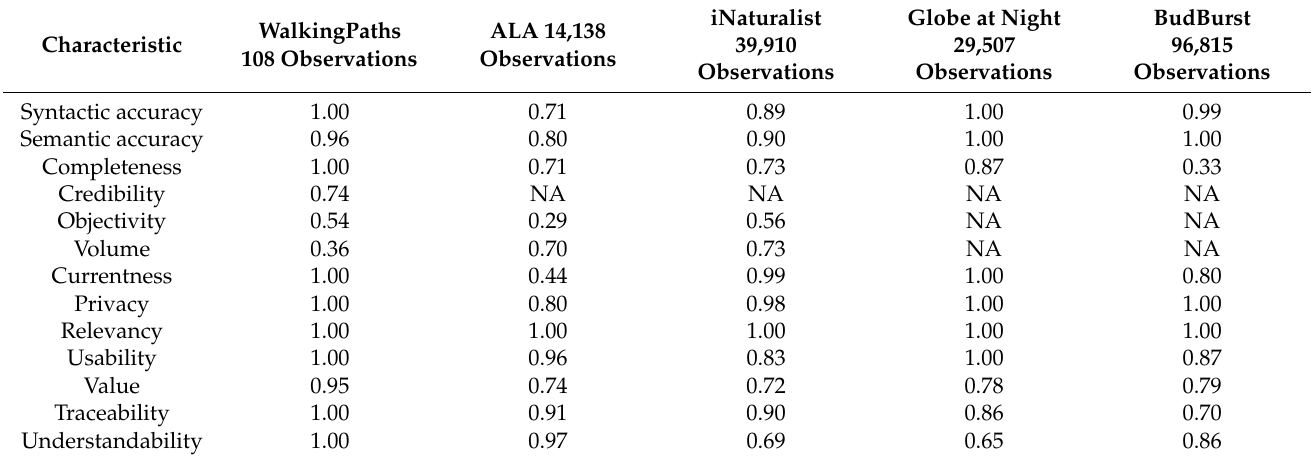
Table 5. WalkingPaths compared to other citizen science